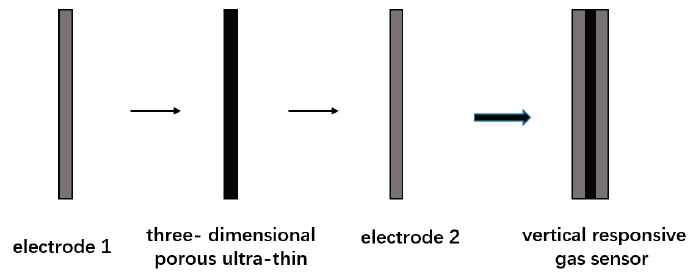
Figure 7. Vertical responsive gas sensor based on 3D porous graphene ultrathin film [64].